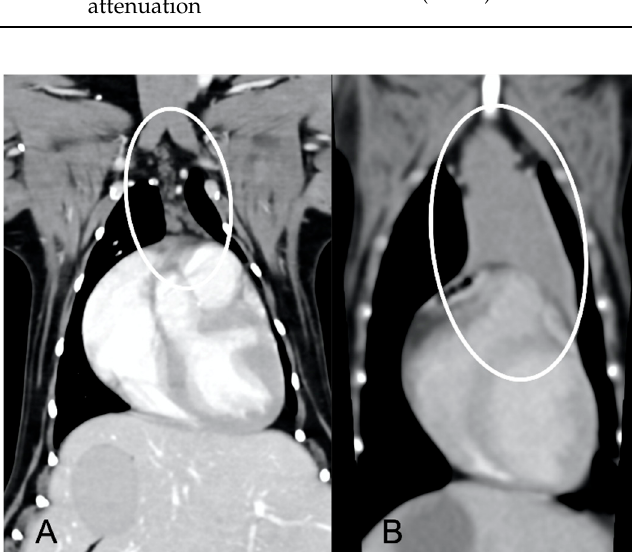
Figure 1. Shape of the thymus (circled) in an adult dog ( A ) compared to a young dog ( B ). Post- contrast dorsal CT reconstruction. Note the different relative sizes of the thymus in the two dogs, and the heterogeneous (lobulated) appearance of the thymus in ( A ) with respect to the thymus in ( B ). In both cases, the shape of the thymus is triangular.